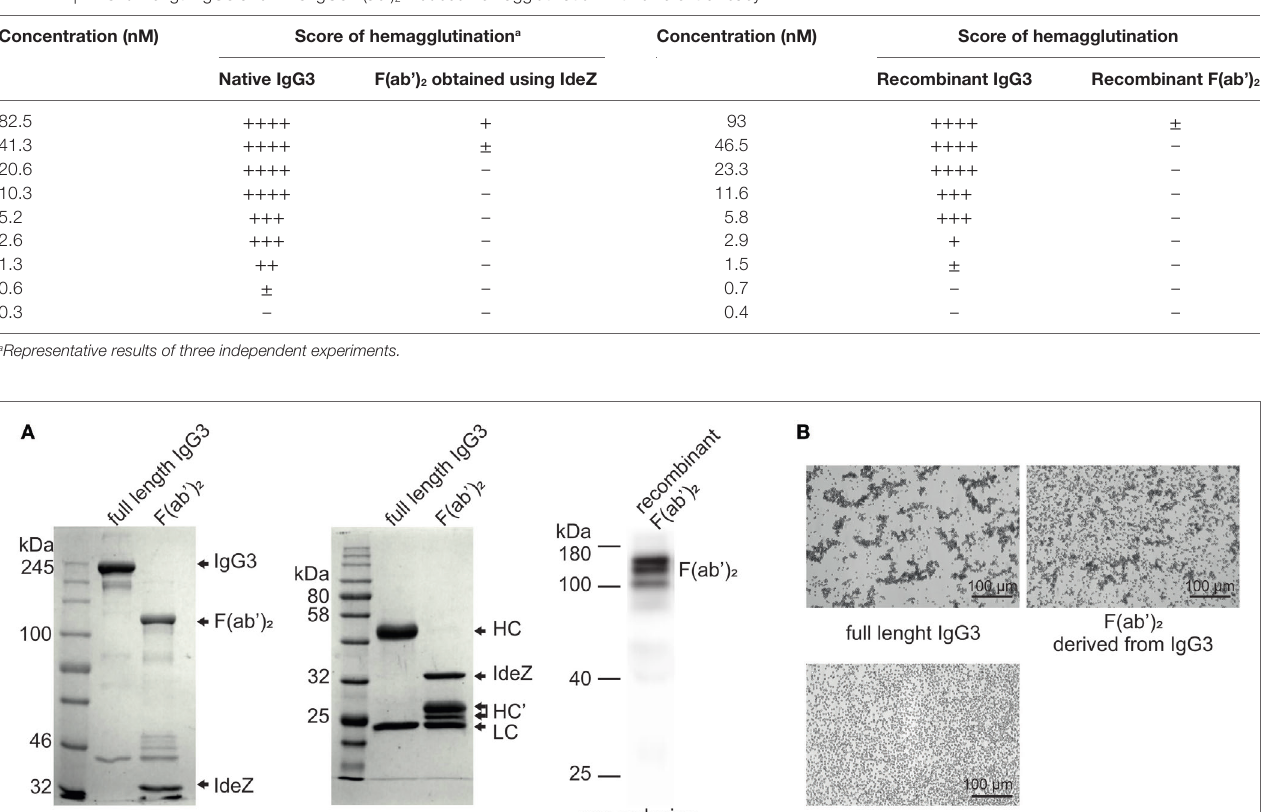
TaBle 1 | M18 full-length IgG3 and M18 IgG3 F(ab’) 2 induced hemagglutination with different